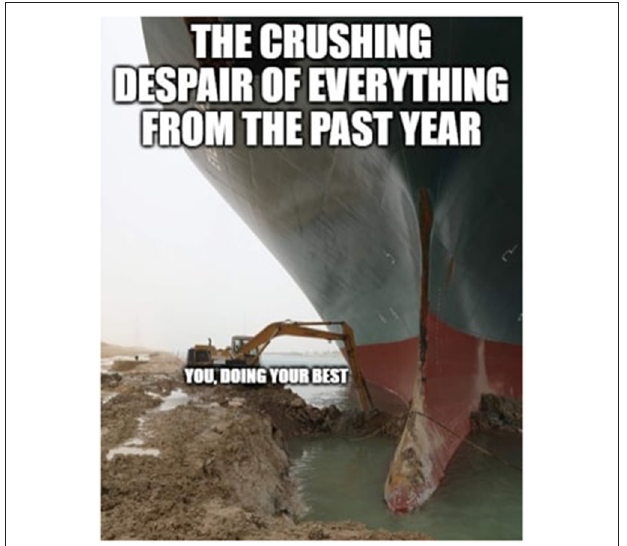
FIGURE 1 | A meme portraying a container ship called the Ever Given , which ran aground in the Suez Canal. The image was posted to Twitter on March 25, 2021 with the words “I made this. It’s for you” ( Streckert,